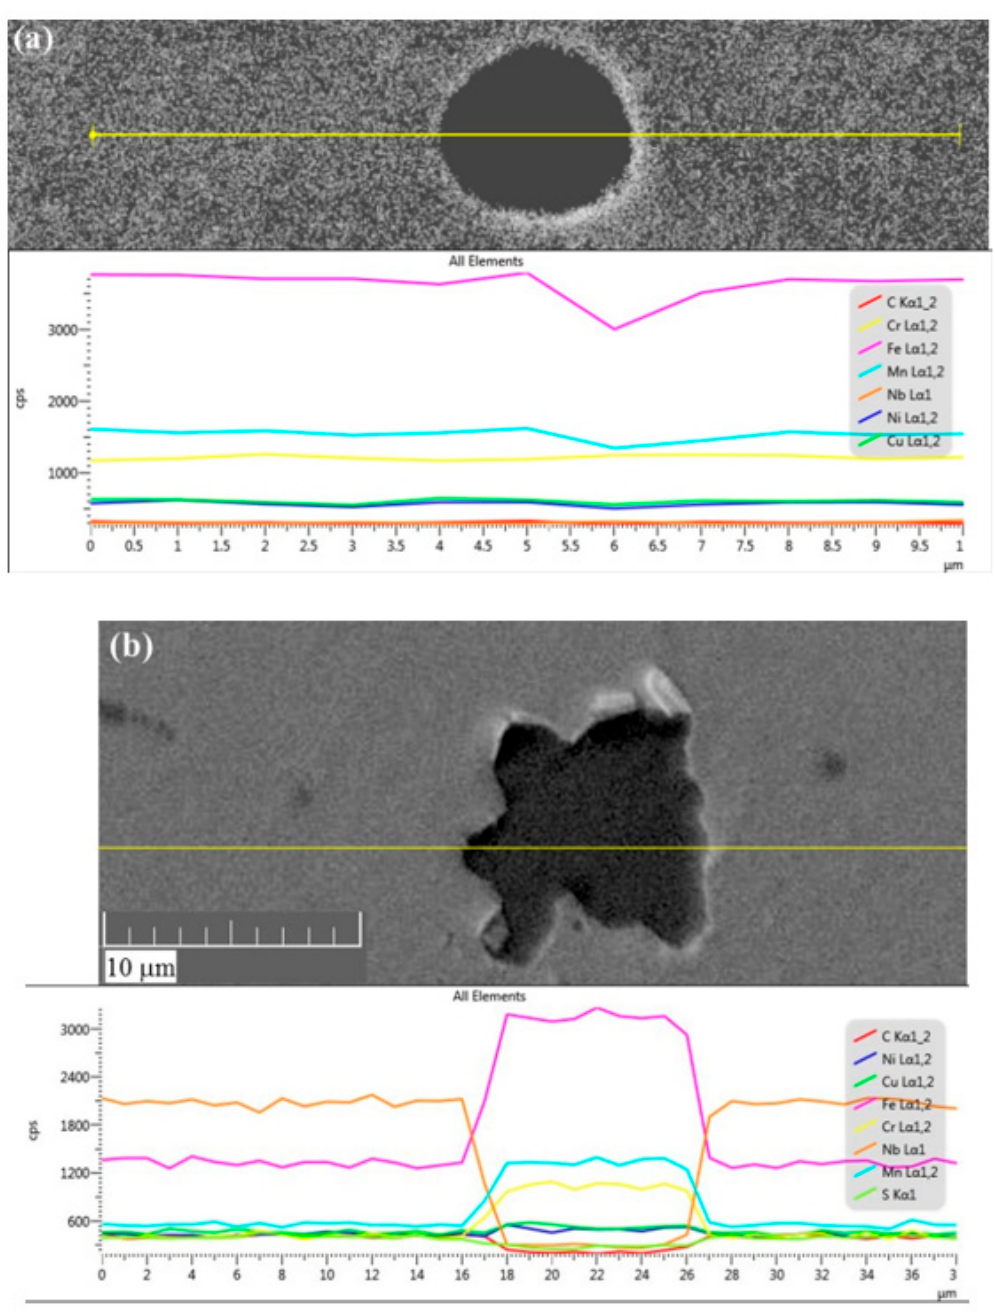
Figure 6. SEM-EDS line scans through typical dark zones in the 17-4 PH stainless steel representing ( a ) pores and ( b ) chemical inhomogeneity.